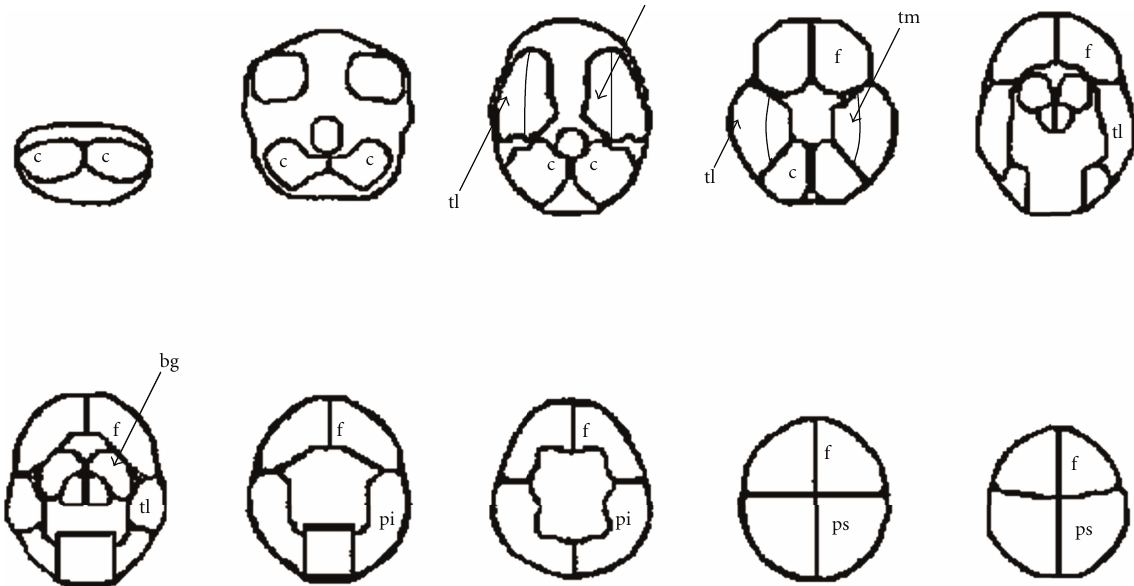
Figure 2: Distribution of regions of interest used for cerebral blood flow estimation. (f) Frontal; (tl) temporal lateral and (tm) temporal mesial; (pi) parietal inferior and (ps) parietal superior ROI; (bg) basal ganglia; (c) reference region in